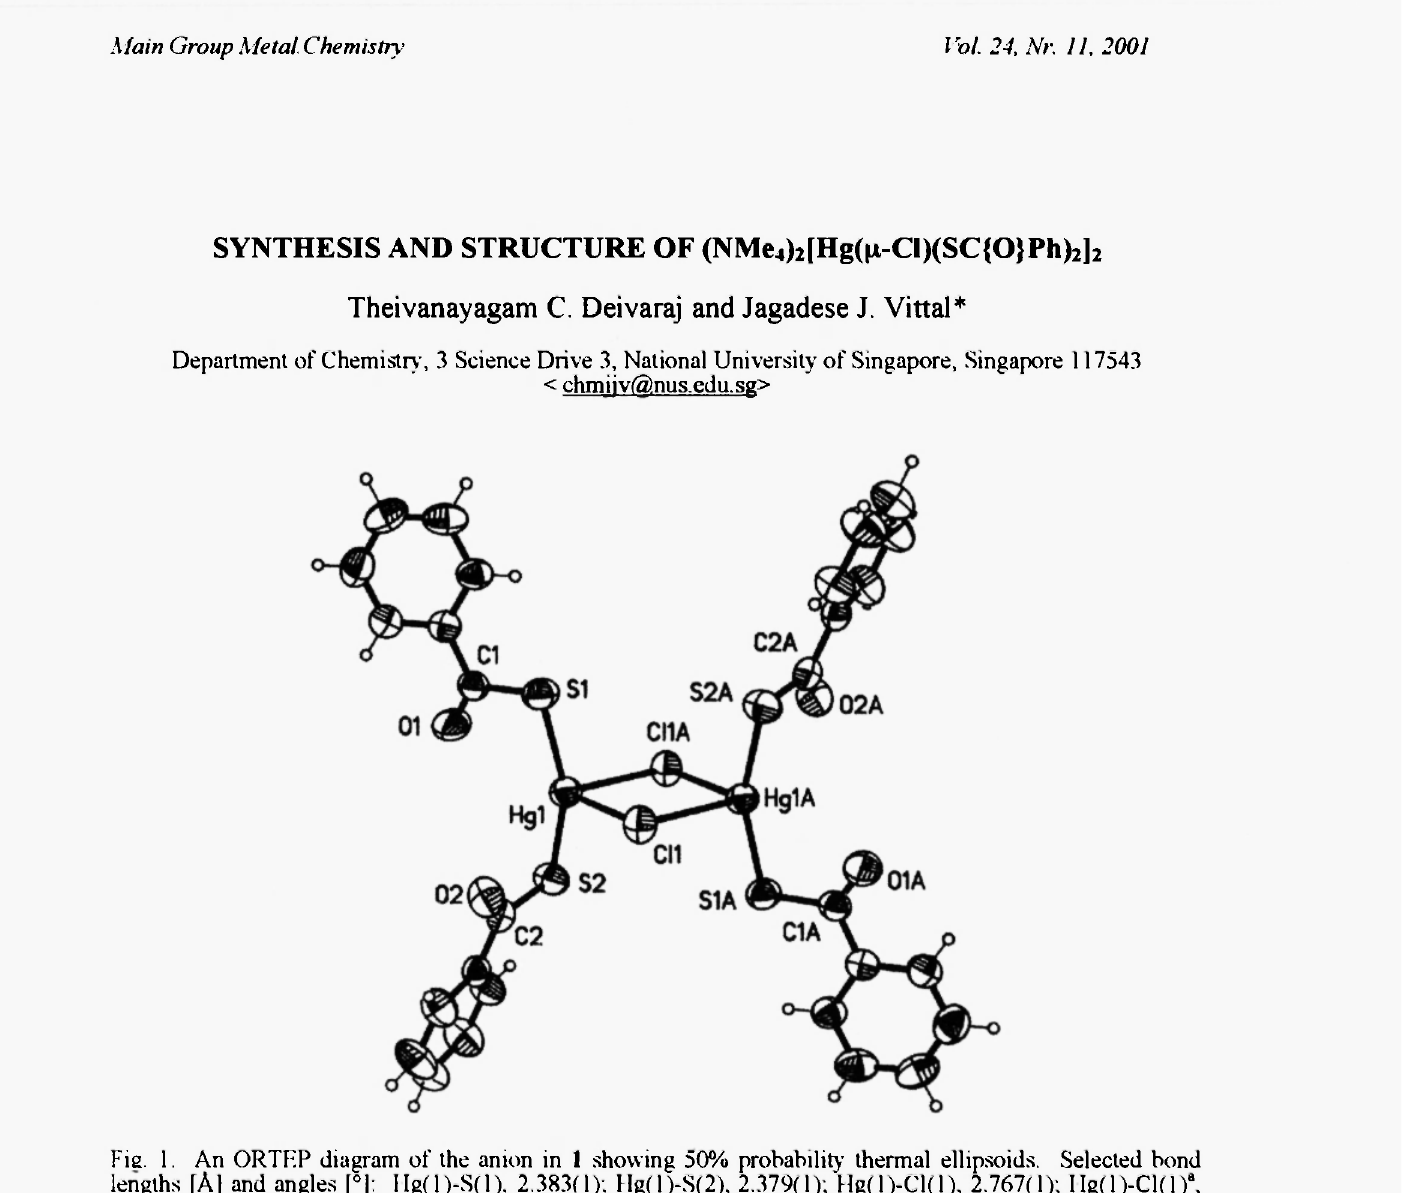
Fie. 1. An ORTEP diagram of the anion in 1 showing 50% probability thermal ellipsoids. Selected bond lengths [A] and angles [°j: IIg(l)-S(l). 2.383(1); Hg(l)-S(2), 2.379(1); Hg(l)-Cl(l), 2.767(1);